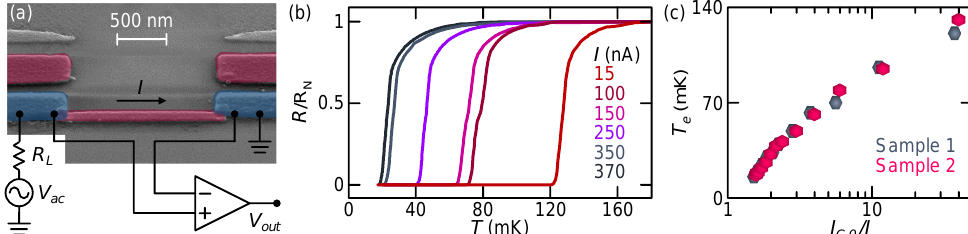
Figure 5. Experimental I -tuning of the transport properties of a 1D-JJ. ( a ) False-color scanning electron micrograph of a typical 1D-JJ. The core of the device is made of an Al/Cu nanowire (purple) in contact with thick Al leads (blue). The nanosensor is AC current-biased (amplitude I ), while the voltage drop across the wire ( V out ) is measured through a lock-in amplifier. R L is a load resistor ( R L (cid:29) R N ). ( b ) Selected normalized resistance ( R / R N ) versus temperature ( T ) characteristics recorded for different values of bias current ( I ). ( c ) Dependence of the escape temperature ( T e ) on the ratio between the zero-temperature critical current and the bias current ( I C ,0 / I ) for two different